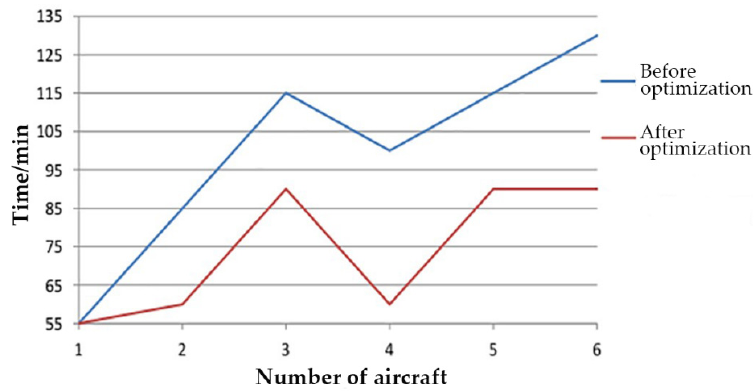
Figure 6. Multi-aircraft support three times before and after scheduling optimization.